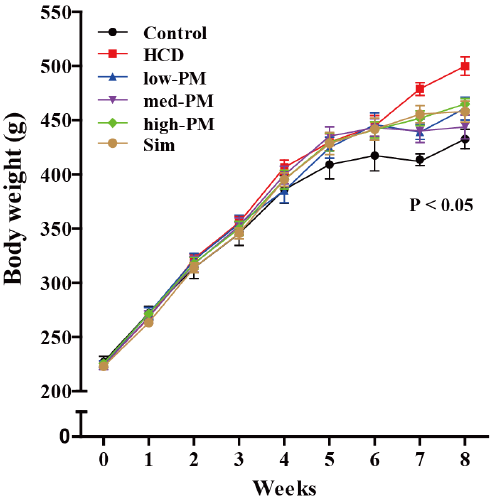
Figure 1. Body weight (BW) changes during experimental procedure. Rats were divided into control, high cholesterol diet (HCD)-fed, and PM-treated groups ( n = 10 per group). BW was measured once a week in each group. p -value for ANOVA for repeated measures is given. HCD, high cholesterol diet-fed group; low-, med-, and high-PM: low (1.65 × 10 9 cfu/kg/day), medium (5.5 × 10 9 cfu/kg/day), and high doses (1.65 × 10 10 cfu/kg/day) of probiotic mixture-treated group, respectively. Table 1. Body weight (BW) and daily food and water intake during experimental procedure. Parameter Control HCD Low-PM Med-PM High-PM Simvastatin